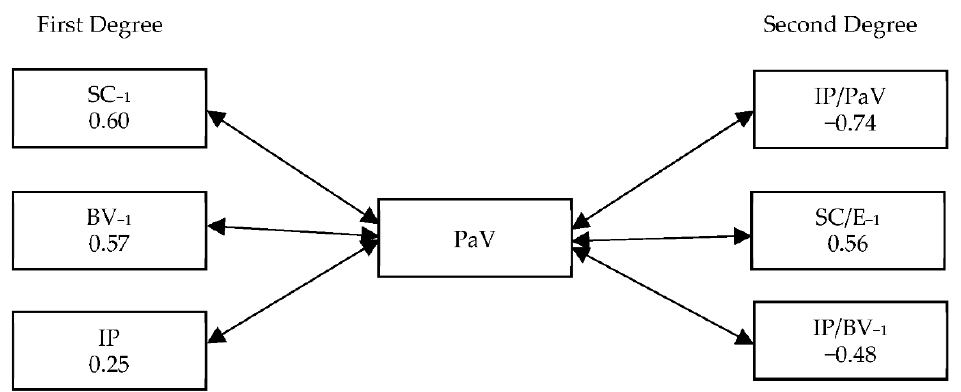
Figure 2. Spearman’s correlation (RS) between par value and financing parameters.